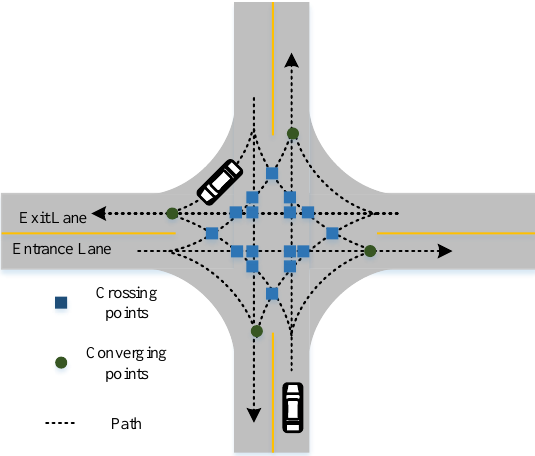
Figure 1. Illustration of the considered single-lane four-way unsignalized intersection scenario.